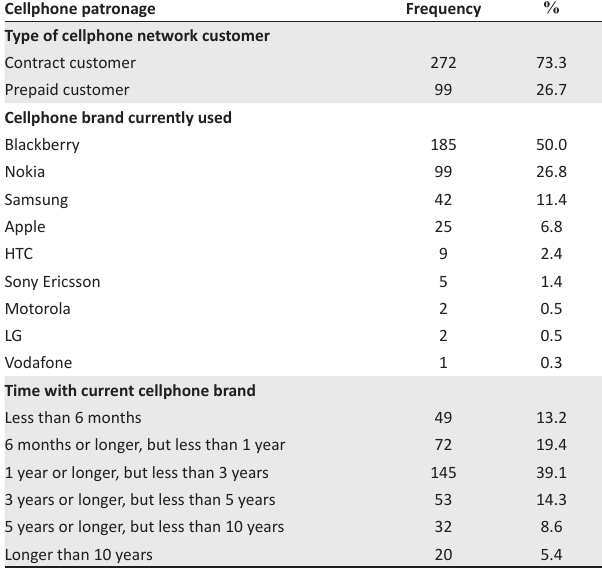
TABLE 2: Cellphone patronage habits of